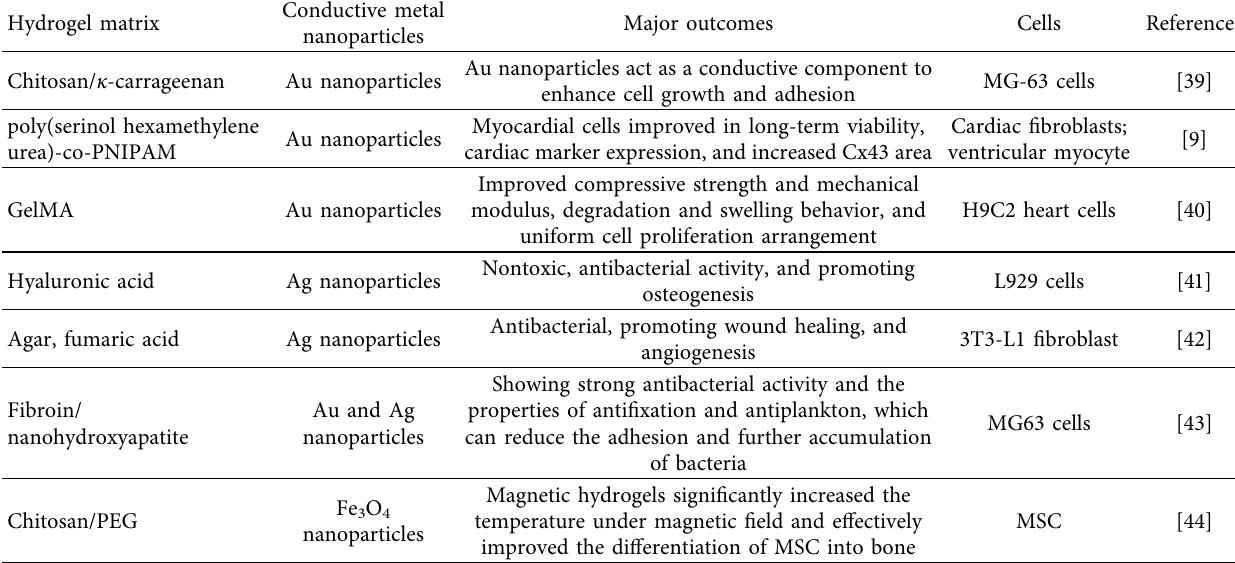
Table 2: Some application of conductive metallic nanoparticle hydrogels in